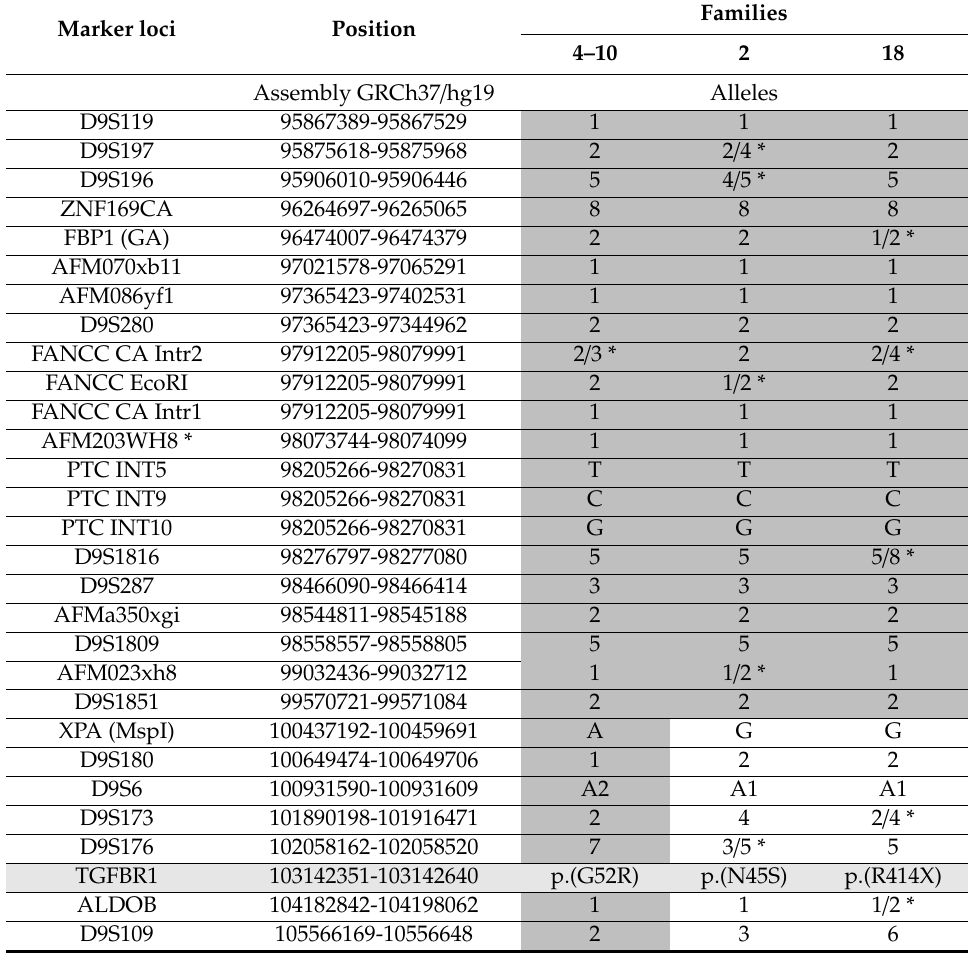
Table 1. Shared haplotypes in Scottish families with common ancestry (modified from Supplementary Material of Reference